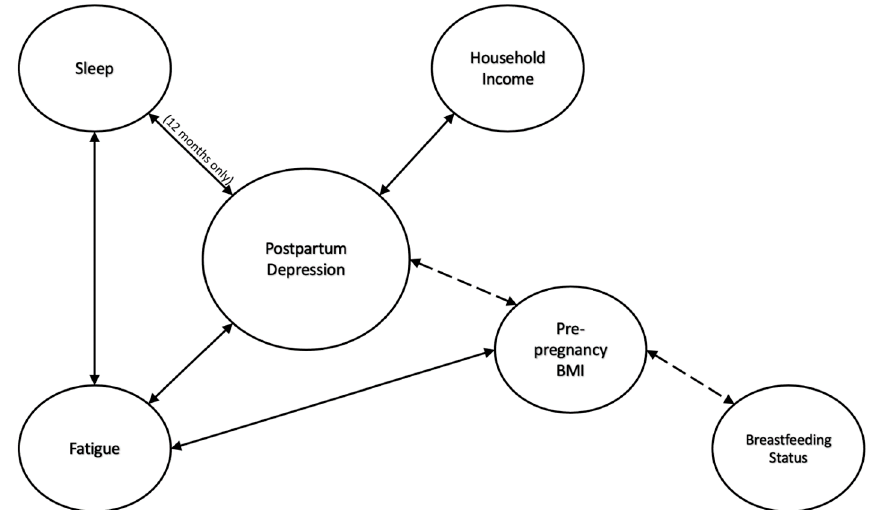
Figure 6. Summary of Study Findings.